Question: According to the figure, is the described quantity increasing or decreasing?
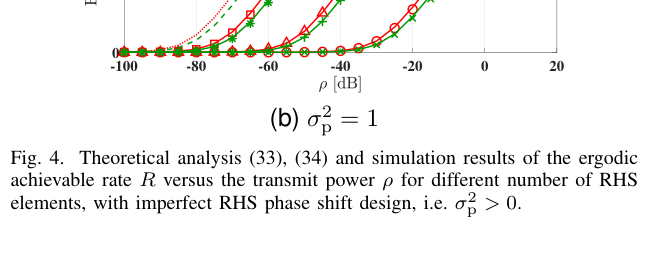
Answer: increasing